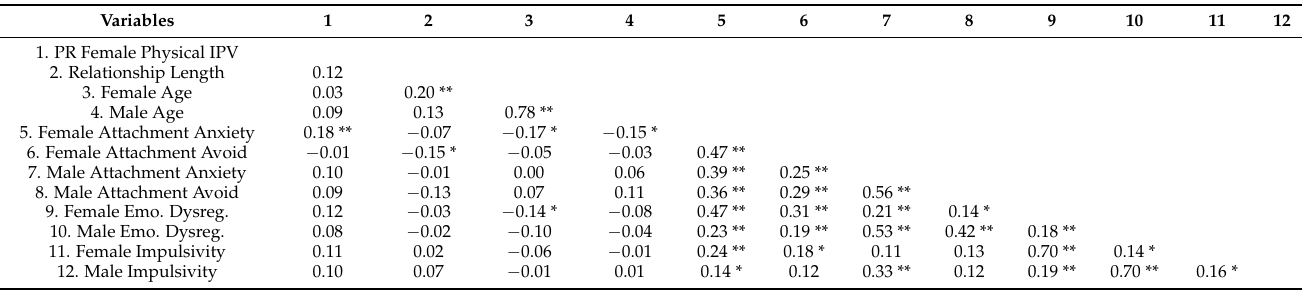
Table 5. Bivariate correlations among partner-reported female IPV, relationship length, age, attachment, emotion dysregula- tion, and